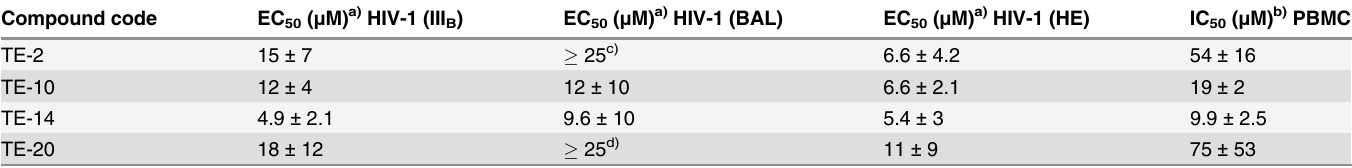
Table 2. Anti-HIV and cytotoxic properties of organotellurium compounds in PHA-stimulated PBMCs. Compound